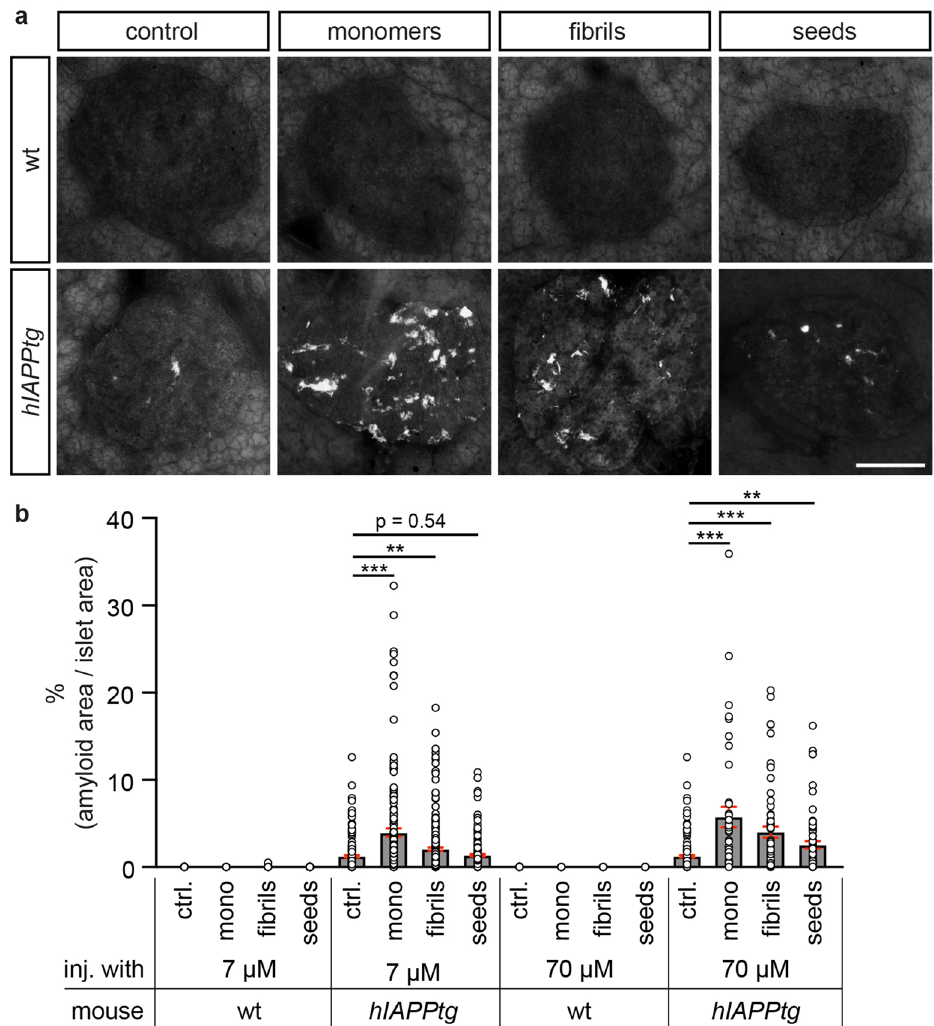
Figure 4. Tail vein injection of αSyn enhances amyloid formation in hIAPPtg mice. Islet amyloid quantification in pancreas from tail vein injected hIAPPtg mice. ( a ) Representative images of Thio-S + amyloid deposits in islets of wild type (wt; upper panel) and hIAPPtg (lower panel) mice tail vein injected with PBS (= control), and 7 µM of hαSyn monomers, fibrils or seeds, respectively. ( b ) Quantification of percentage Thio-S + amyloid area/islets area of wild type and hIAPPtg mice tail vein injected with PBS (= ctrl.), 7 and 70 µM hαSyn monomers, fibrils or seeds, respectively. Please see “Amyloid analyses” in the Materials and methods section for information on numbers of islets and mice analysed for each category. Scale bar is 100 µm. Data are presented as mean + /− SEM, ** P < 0.01, *** P < 0.001 (Student’s